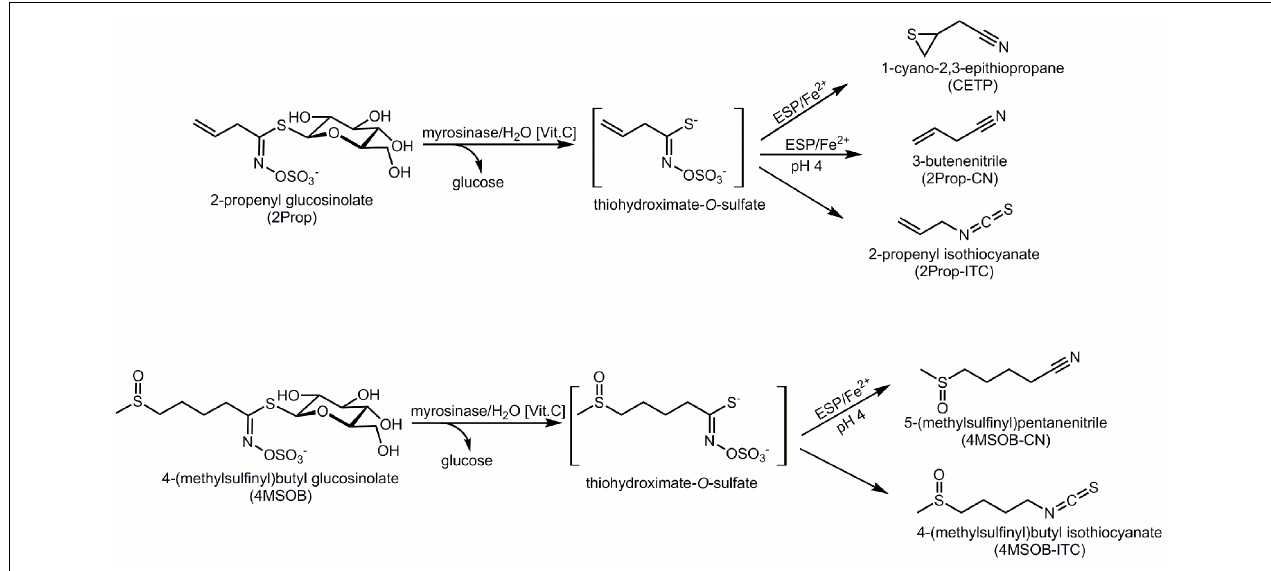
FIGURE 1 | Enzymatic hydrolysis pathways of 2-propenyl glucosinolate (2Prop) and 4-(methylsulfinyl)butyl glucosinolate (4MSOB). ESP, epithiospecifier protein. The glucosinolate hydrolysis is started by myrosinase induced degradation with vitamin C being a cofactor for this enzyme. The resulting thiohydroximate- O -sulfate intermediate either spontaneously degrades to the isothiocyanate (ITC) and under acidic conditions to the nitrile. In presence of ESP, which is dependent on Fe 2 + , the formation of the epithionitrile from the alkenyl intermediate (2Prop) or of the nitrile from the non-alkenyl intermediate (4MSOB) is catalyzed.